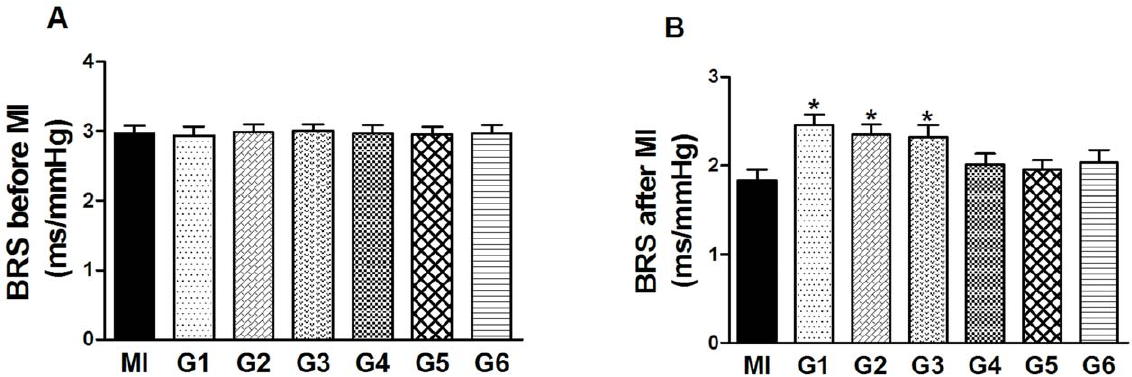
Figure 7. Impacts of vagal stimulation on baroreflex sensitivity (BRS) change. BRS was quantitated as slope of a line generated from the relationship of R-R interval during increases in arterial pressure. (A) The BRS baseline level in each group at the stabilization period. (B) The BRS levels in each group at the end of experiment. The levels of BRS were obviously higher in G1, G2 and G3 compared with the MI group. Data are the mean 6 SEM (n=8). * P , 0.05 compared with MI